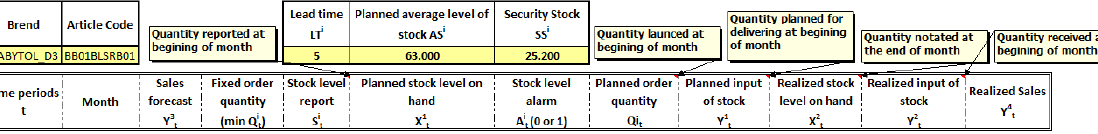
Figure 4. Elements of the spreadsheet model.